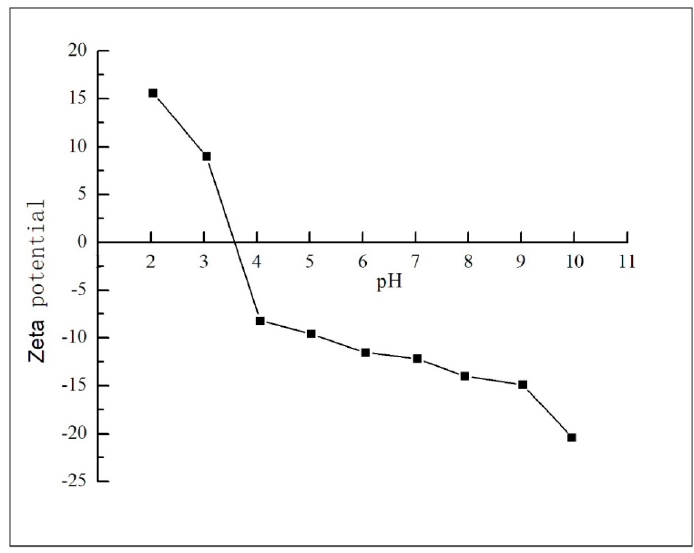
Figure 2. E ff ect of pH on zeta potential of Fe 3 O 4 . Figure 2. Effect of pH on zeta potential of Fe 3 O 4.